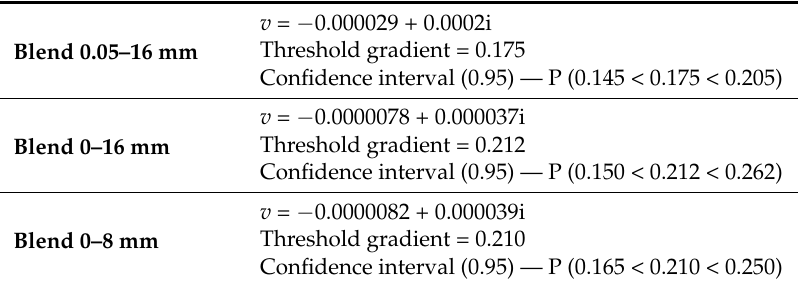
Table 4. Summary of the calculation results for the threshold gradient